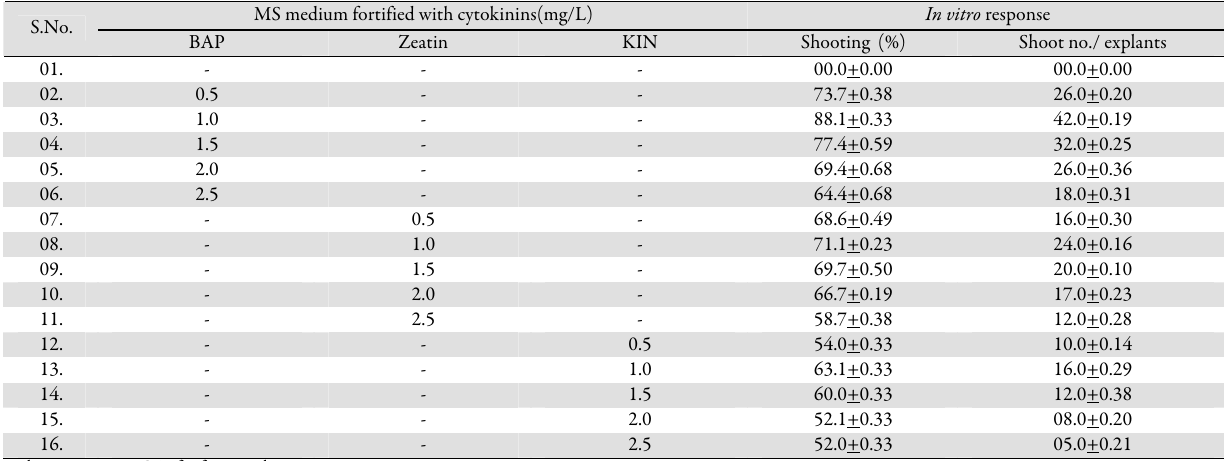
Table 1. Effect of cytokinins on axillary meristems of Physalis angulata L. at four weeks of culture MS medium fortified with cytokinins(mg/L) In vitro response